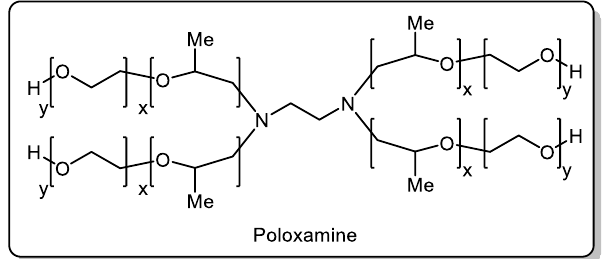
Figure 8. The chemical structure of